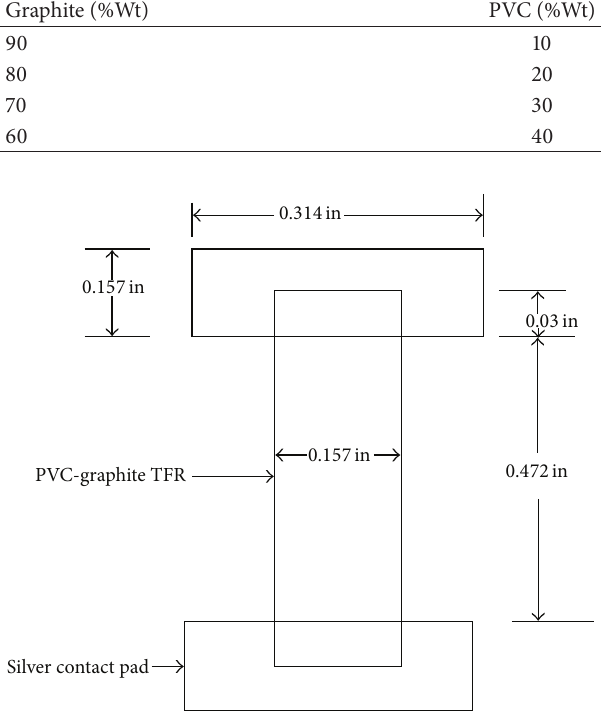
Figure3:Normalizedresistancevariationwithnumberofpulsesfor different pulse